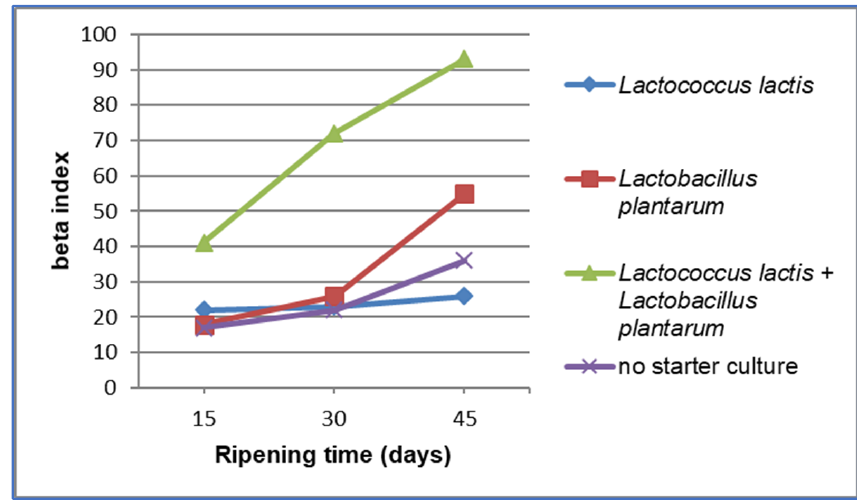
Figure 4. Beta index of Sir iz mišine at 15, 30, and 45 days of ripening.